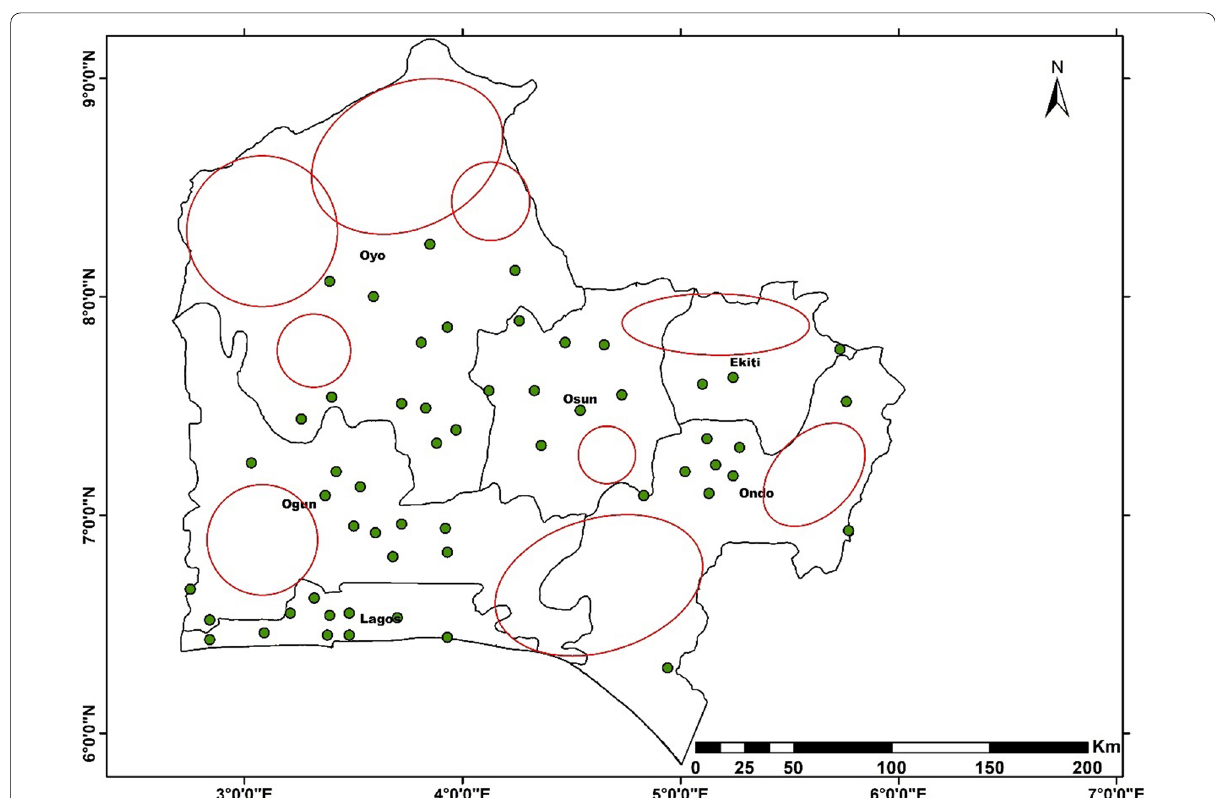
Fig. 2 Occurrence record (green dots) of An. gambiae used for model calibration and areas needing further sampling (red line